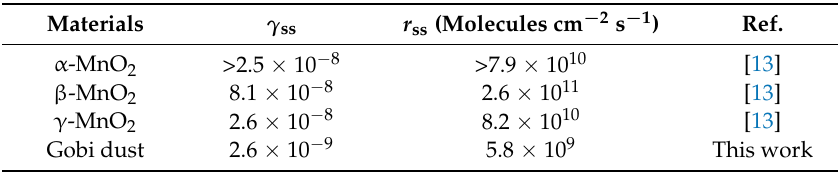
Table 2. Comparison of γ ss and r ss determined in the presence of 10 ppm of ozone on natural Gobi dust and 14 ppm of ozone on MnO 2 under atmospheric pressure and at room